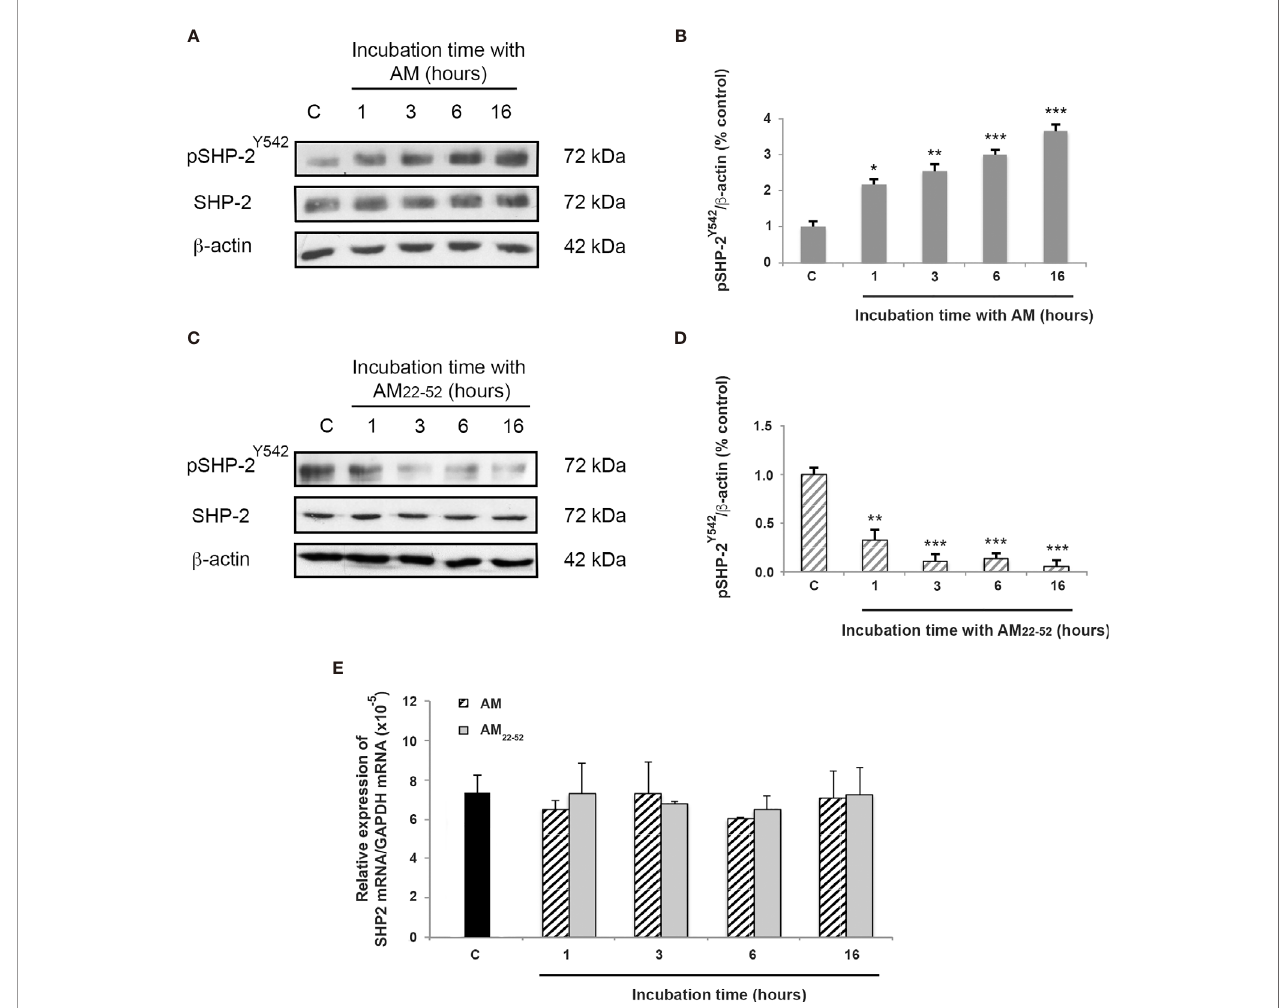
FIGURE 2 | AM activates SHP-2 by inducing its phosphorylation on tyrosine 542. (A, C) Total cell lysates isolated from HUVECs treated with AM (10 -9 M) or AM 22-52 (10 -6 M) was subjected to immunoblotting for SHP-2 and pSHP-2 Y542 , as indicated. (A, B) AM (10 -9 M) signi fi cantly increases the phosphorylation of SHP-2 Y542 in a time-dependent manner. (C, D) AM antagonist AM 22-52 (10 -6 M) decreases the phosphorylation of SHP-2 Y542 in a time-dependent manner. Blotting for b -actin was used to control equal loading. Molecular weights are shown. * p < 0.05; ** p < 0.01; *** p < 0.001. (E) Expression of SHP-2 mRNA in HUVECs. Total RNA (1 m g, DNA free) prepared from HUVECs treated with AM (10 -9 M) or AM 22-52 (10 -6 M) at the indicated time was reverse-transcribed into cDNA and subjected to real-time quantitative RT-PCR for the estimation of the relative ratios of SHP-2 mRNA to GAPDH mRNA as described in Materials and Methods. Each experiment is representative of eleven (B, D) and fi ve (E) independent experiments. Results are shown as means ±